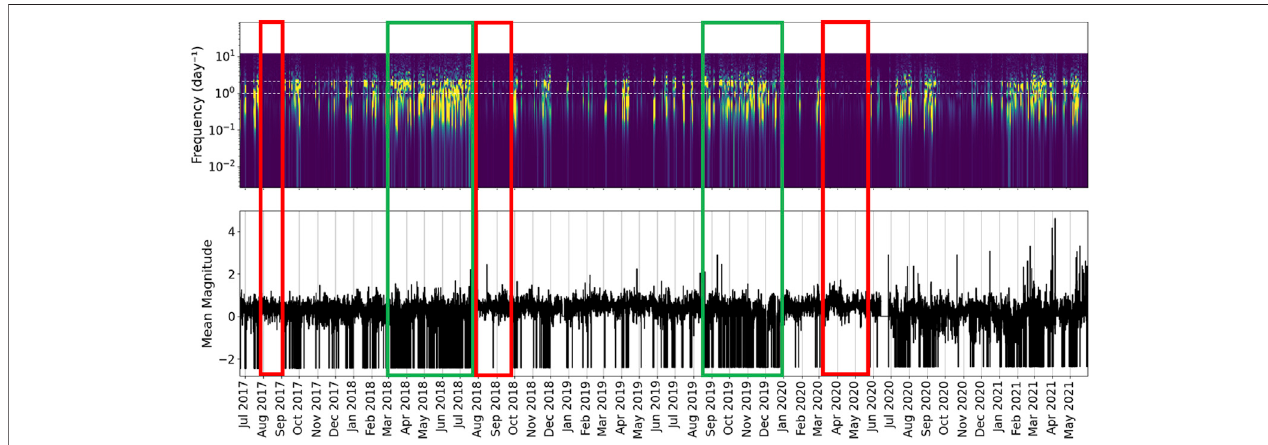
FIGURE 2 | Top: spectrogram showing the dominant frequencies (bright colors) present in the sonar magnitude data over time. The two horizontal dashed lines show the locations of the diurnal (lower line) and semi-diurnal (upper line) tidal frequencies. Bottom: timeseries of the sonar magnitude data (without DC component). Magnitudedataaredimensionless.Thediurnalandsemi-diurnaltidalfrequenciesarethedominantfrequencyconstituentsofthesonardataindicatingatidalin fl uenceon thegasemissions.However,thetidalfrequenciesarenotcontinuouslydetectableinthesonardataindicatingthatthestrengthofthetidalin fl uencevariesovertime. Intervals when venting is frequently interrupted coincide with intervals of strong tidal in fl uence (green boxes). By contrast, tidal in fl uence is low at times when venting is continuously active and rarely stops (red boxes).